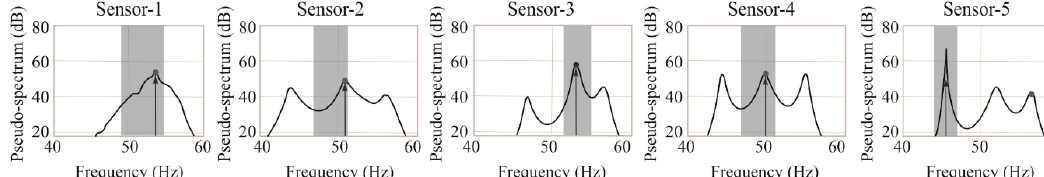
Figure 8. Pseudo-spectra estimated by using the MUSIC method for the healthy condition and five sensors and damage index (DI) estimation.